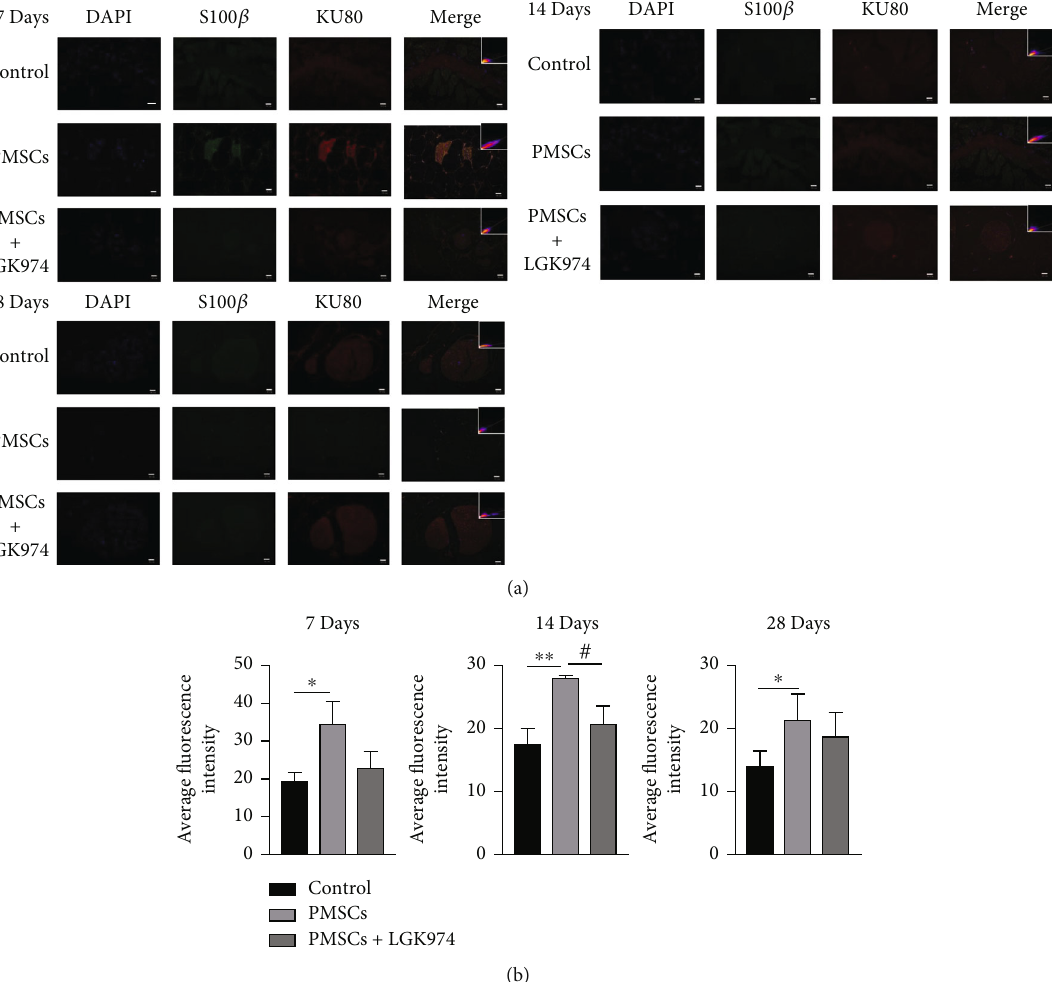
Figure 6: Relationship between Schwann cells and PMSCs. (a) The results of immuno fl uorescence showed that compared with the control group S100 β in the PMSC group was highly expressed at 7, 14, and 28 days after treatment ( P < 0 : 05 ); the expression of S100 β in the LGK974 treatment group was signi fi cantly lower than that in PMSC group on 14 days. Fluorescence colocalization showed that the expression of S100 β and KU80 overlapped in the same position after PMSC treatment. (b) Quantitative measurements were expressed as mean fl uorescence intensity. Data were mean ± SEM . n = 3 per each group. ∗ PMSC group vs. control group, P < 0 : 05 ; # PMSC group vs. PMSC+LGK974 group, P < 0 : 05 . The scale bar: 50 μ